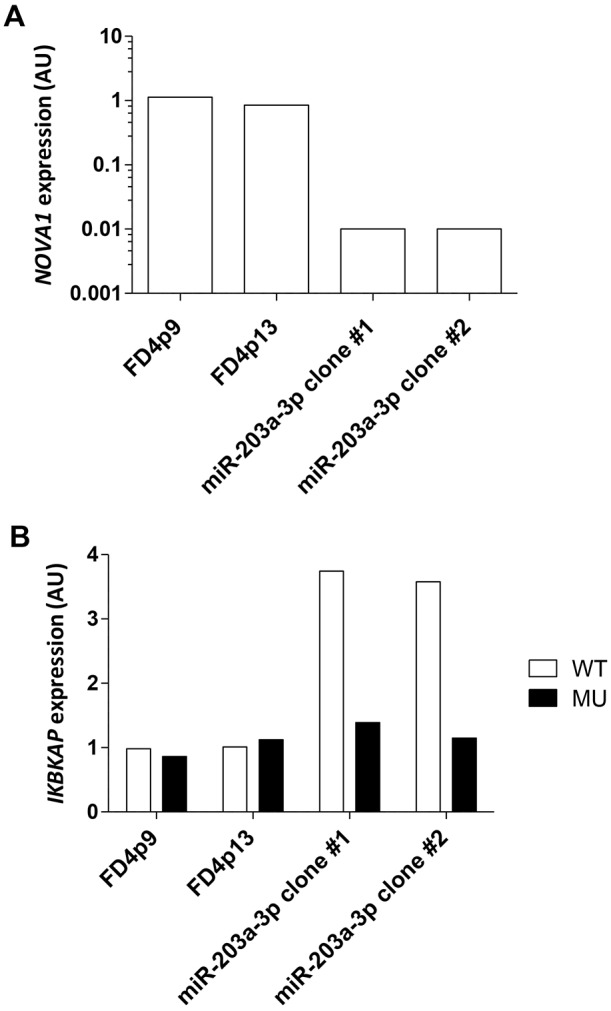
miR-203a-3p overexpression induces antagonistic effects on NOVA1 and IKBKAP WT transcripts levels. Histograms represent the level of expression of NOVA1 mRNA (A) and IKBKAP transcripts (B) in two primary cultures of FD hOE-MSCs at different cell passages (p9 and p13) and two FD clones (#1 and #2) obtained after transduction with miR-203a-3p lentiviral constructs, as determined by RT-qPCR. WDR59 was used to normalize mRNA expression. The expression of each gene was determined relative to the median value of non-transduced FD hOE-MSCs (set at 1).